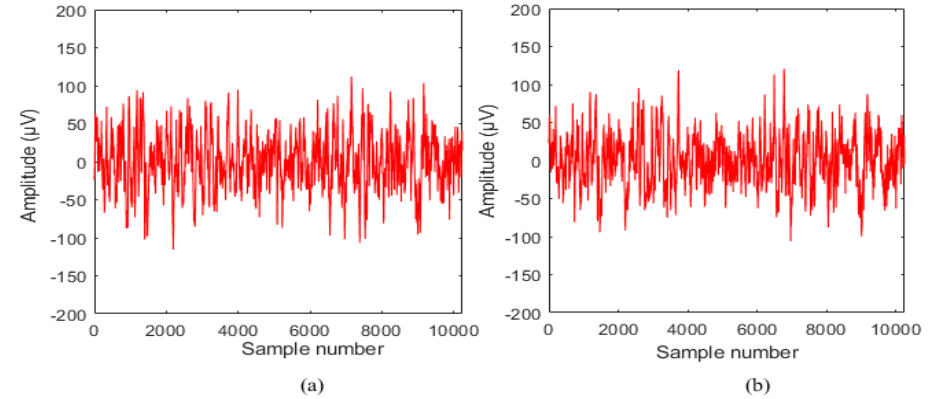
Figure 3. A sample of focal class (FC) EEG signal ( a ) x channel and ( b ) y channel.